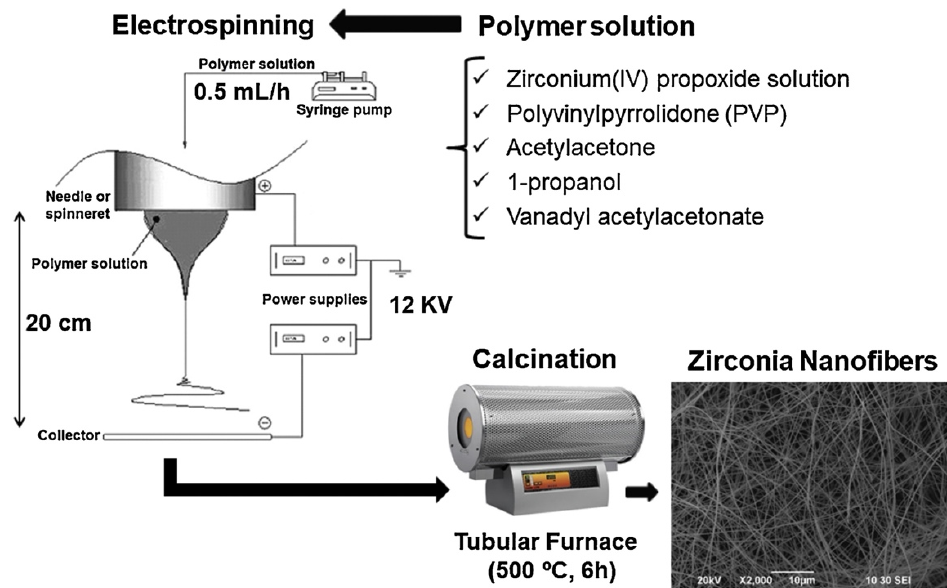
Figure 4. Schematic procedure followed for the preparation of vanadium-containing Zirconia submicron-fibers. Reproduced from [98] with permission from the copyright owner (Elsevier 2019).